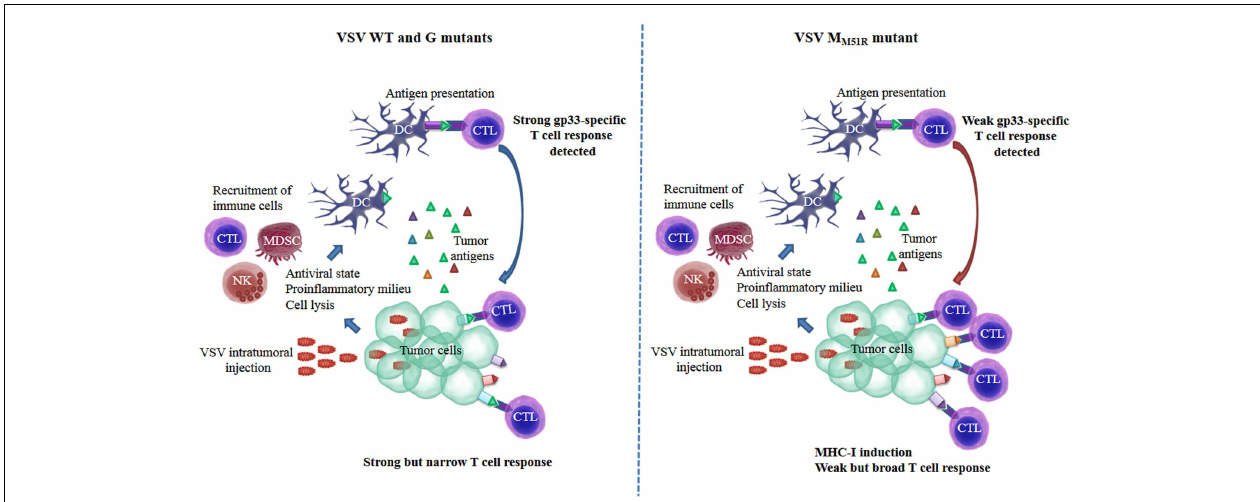
induces a strong CD8 + cytotoxicT lymphocyte (CTL) response against a surrogate non-self antigen (gp33) correlating with their ability to limit tumor growth (left panel). In contrast, the matrix mutant ofVSV (M M51R ), although inefficient at inducing gp33-specific CTLs, is highly effective at slowing down tumor progression, likely through its capacity to induce the upregulation of MHC-I surface expression on cancer cells allowing for the induction of a broader CTL response (right panel). CTLs, cytotoxicT lymphocytes; DC, dendritic cells; MDSC, myeloid-derived suppressor cell; MHC-I, major histocompatibility complex class I; NK, natural killer;VSV, vesicular stomatitis